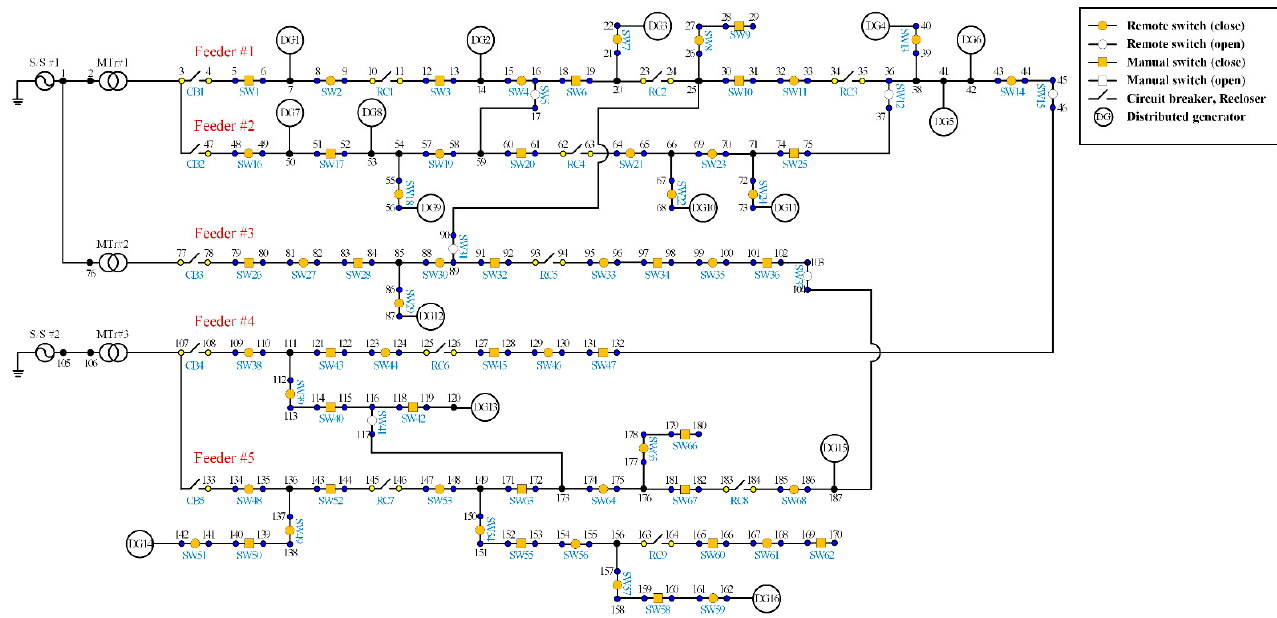
Figure 12. Test system.